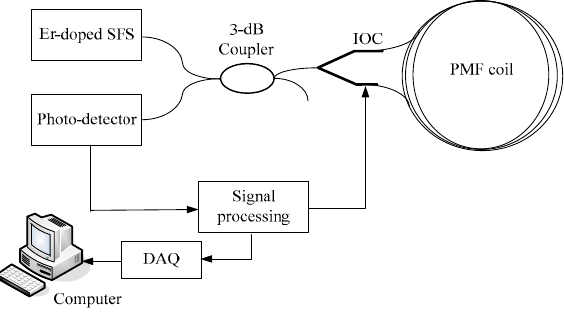
Figure 1. Schematic diagram of digital closed-loop interferometric fiber optic gyroscope (IFOG).